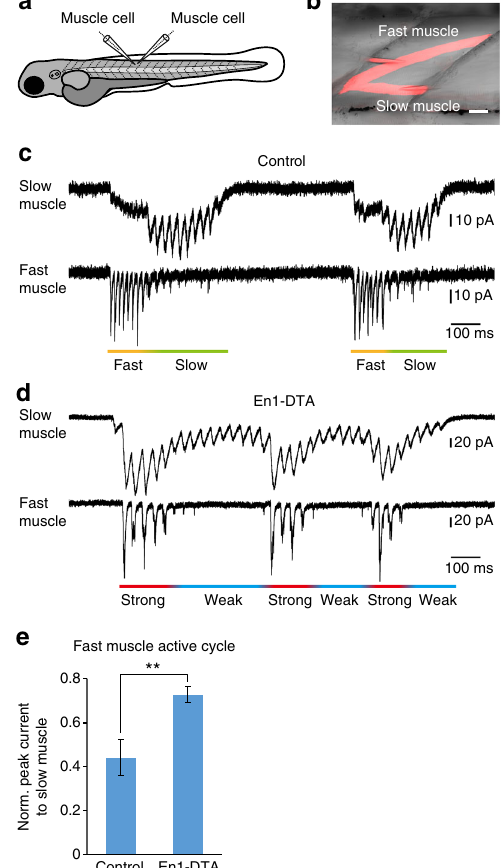
Fig. 6 Voltage-clamp recordings of fast and slow muscles in control and En1-DTA fi sh. a A schematic illustration of the simultaneous voltage-clamp recordings of two muscle cells (one for a fast muscle, the other for a slow muscle). Neuro-muscular transmission was partially blocked in these experiments, and portions of synaptic currents remained in the recording conditions. b An image after a recording. Slow and fast muscles were morphologically distinct and could be easily distinguished. Scale bar, 20 μ m. c Example of simultaneous voltage-clamp recordings in control fi sh. d Example of simultaneous voltage-clamp recordings in En1-DTA fi sh. e Normalized currents in the slow muscle cells in the cycle when the fast muscle received strong inputs (>50% of the maximum). Five paired recordings were performed. Control: 0.44 ± 0.08, En1-DTA: 0.73 ±